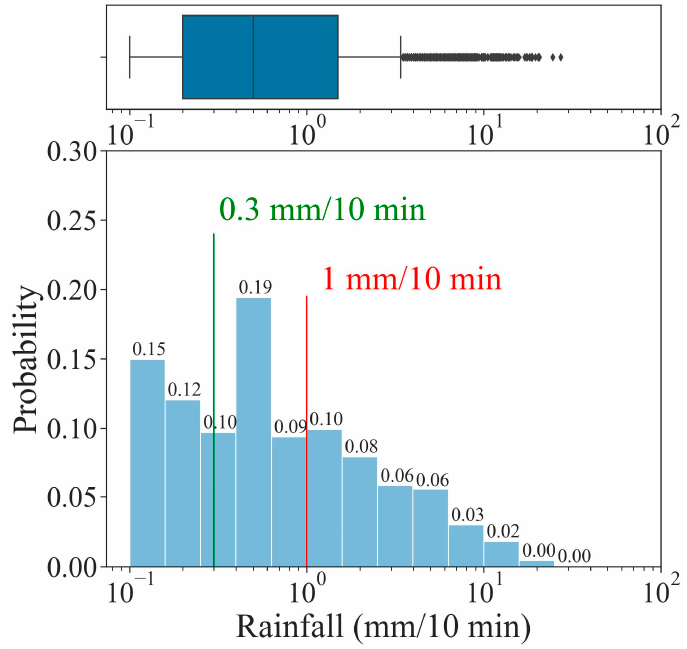
Figure 2. The observed rainfall probability distribution of all rain gauges in the study area during the summer of 2018–2019, in which the green line represents the 33.33% quantile and the red line represents the 66.66% quantile. The above figure is the box chart of rainfall intensity, with the 25th, 50th, and 75th percentiles represented from left to right. While the outside of the box extends to 1.5 times the quartile deviation (25th to 75th percentile), the outliers are indicated by black dots.